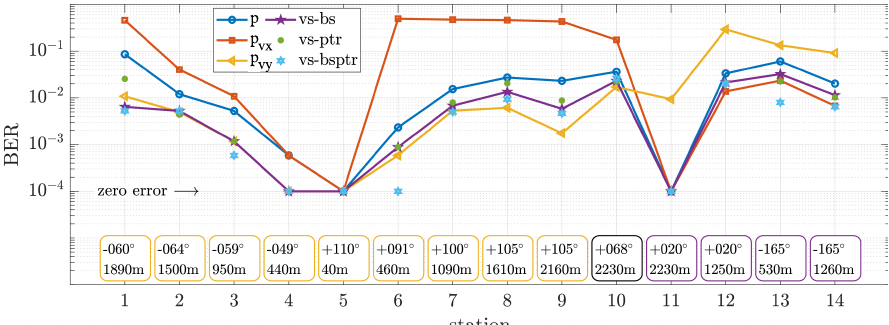
Figure 10. BER performance for pressure ( p ), directional components ( p vx and p vy ), vector sensor beam steering (vs-bs), vector sensor passive time-reversal (vs-ptr), and the joint vector sensor beam steering and passive time-reversal (vs-bsptr). Bottom boxes display the source direction and range for convenience.